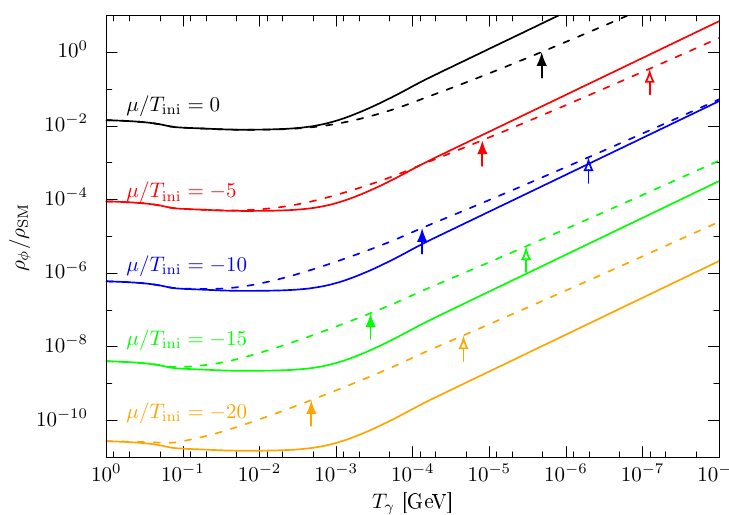
Figure 4. The solid (dashed) lines show the cosmological evolution of the energy density of the stable φ without (with) self-thermalization. In both cases, we take m φ = 2 MeV. The arrows with fill and with empty fill indicate the freeze-out temperature of the φφφ ↔ φφ process with the perturbative cross section in eq. (3.8) ( µ φ = m φ , λ s = 0 ) and the unitarity-bound-saturated cross section in eq. (3.9),